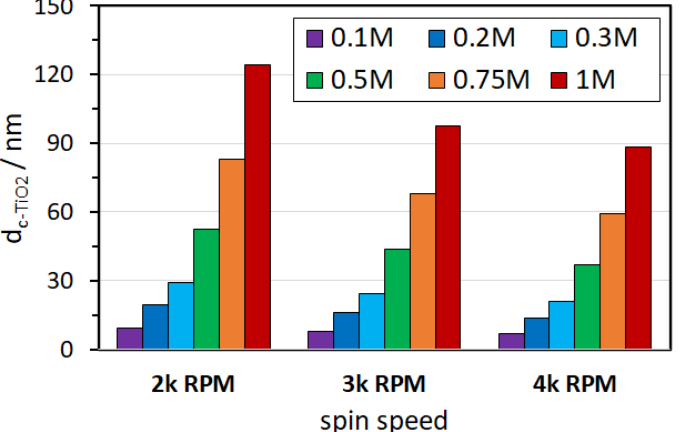
Figure 2. The dependence of the thickness of the c-TiO 2 layer on the spin speed (in 10 3 revolutions per minute) in the spin-coating process for different concentrations of Ti(acac) 2 OiPr 2 in the 1-BuOH precursor .